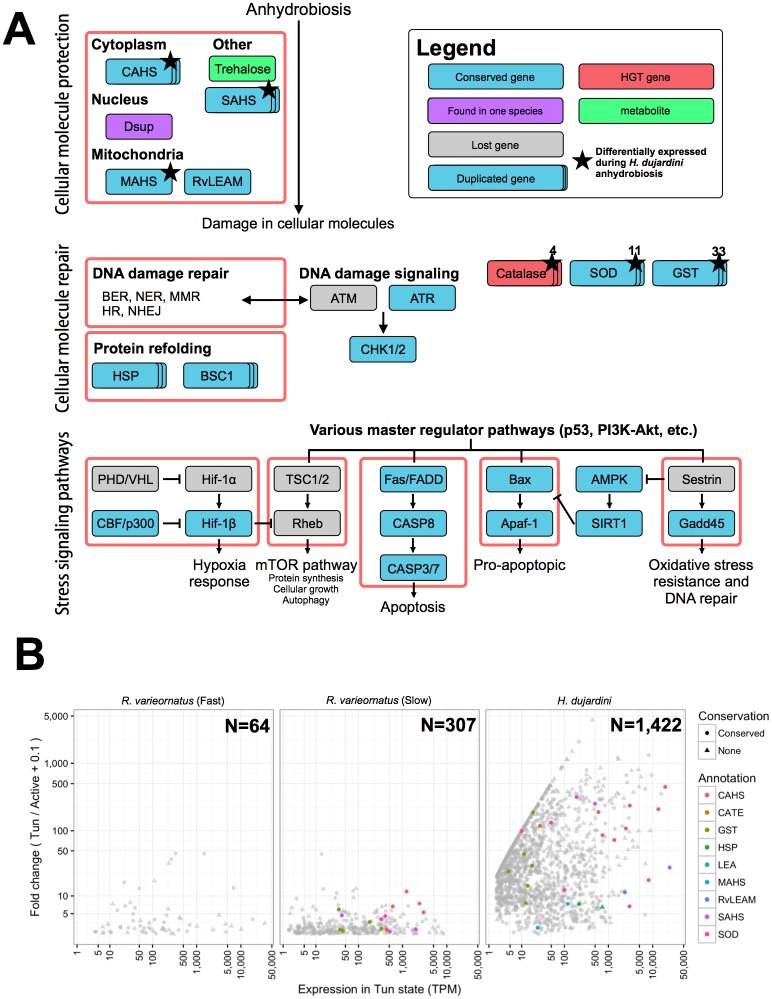
The genomics of anhydrobiosis in tardigrades.(A) Gene losses in Hypsibiidae. Gene losses were detected by mapping to Kyoto Encyclopedia of Genes and Genomes (KEGG) pathways using KEGG Automatic Annotation Server (KAAS) and validated by Basic Local Alignment Search Tool (BLAST) TBLASTN search of KEGG orthologue gene amino acid sequences. Light blue and gray boxes indicate genes conserved and lost in both tardigrades, respectively. Furthermore, purple boxes represent genes retained in only 1 species, and red boxes represent genes that have been detected as horizontal gene transfer (HGT). The numbers on the top right of the boxes indicate copy numbers of multiple copy genes in H. dujardini. Genes annotated as CASP3 and CDC25A have contradicting annotation with KAAS and Swiss-Prot; however, the KAAS annotation was used. (B) Differential gene expression in tardigrades on entry to the anhydrobiotic state. The transcript per million (TPM) expression for each sample was calculated using Kallisto, and the fold change between active and tun and the TPM expression in the tun state were plotted. Genes that likely contribute to anhydrobiosis were colored. Genes that had an orthologue in the other species are plotted as circles; other genes are plotted as triangles. Data available at https://github.com/abs-yy/Hypsibius_dujardini_manuscript/blob/master/data/Fig3B_gene-expression-DEGs-FCandTUN-annotated.txt. AMPK, 5' adenosine monophosphate-activated protein kinase; ATM, ataxia-telangiectasia mutated; ATR, ataxia telangiectasia and Rad3-related protein; BER, base excision repair; BSC1, bypass of stop codon protein 1; CAHS, cytosolic abundant heat soluble; CASP8, caspase 8; CATE, catalase; CBF, C-repeat-binding factor; CHK1/2, checkpoint kinase 1/2; Dsup, damage suppressor; GST, glutathione S-transferase; HR, homologous recombination; HSP, heat shock protein; MAHS, mitochondrial abundant heat soluble protein; MMR, mismatch repair; mTOR, mechanistic target of rapamycin; NER, nucleotide excision repair; NHEJ, nonhomologous end joining; RvLEAM, late embryogenesis abundant protein mitochondrial; PHD, plant homeodomain; SAHS, secretory abundant heat soluble; SIRT1, sirtuin 1; SOD, superoxide dismutase; TSC1/2, tuberous sclerosis 1/2; VHL, von Hippel-Lindau tumor suppressor.